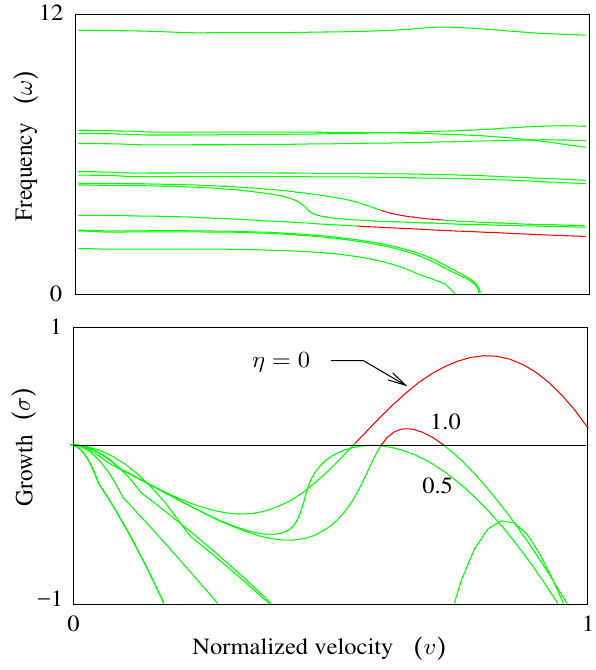
Figure 6. Processes 1, 3 and 4: V - σ - ω at three η (Green means stable, red means